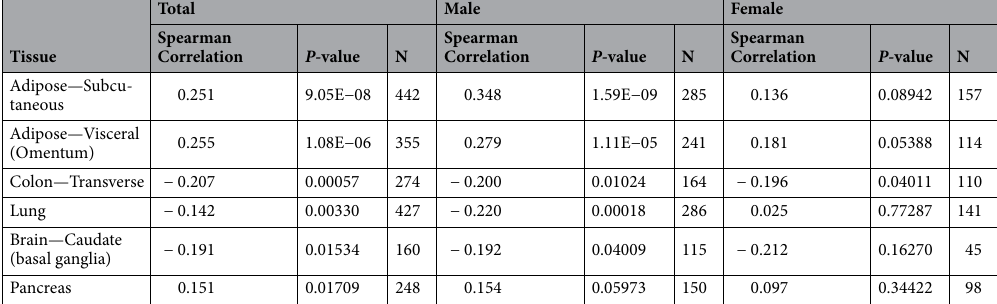
Table 1. Tissues with significant correlation between TREM2 expression and BMI.